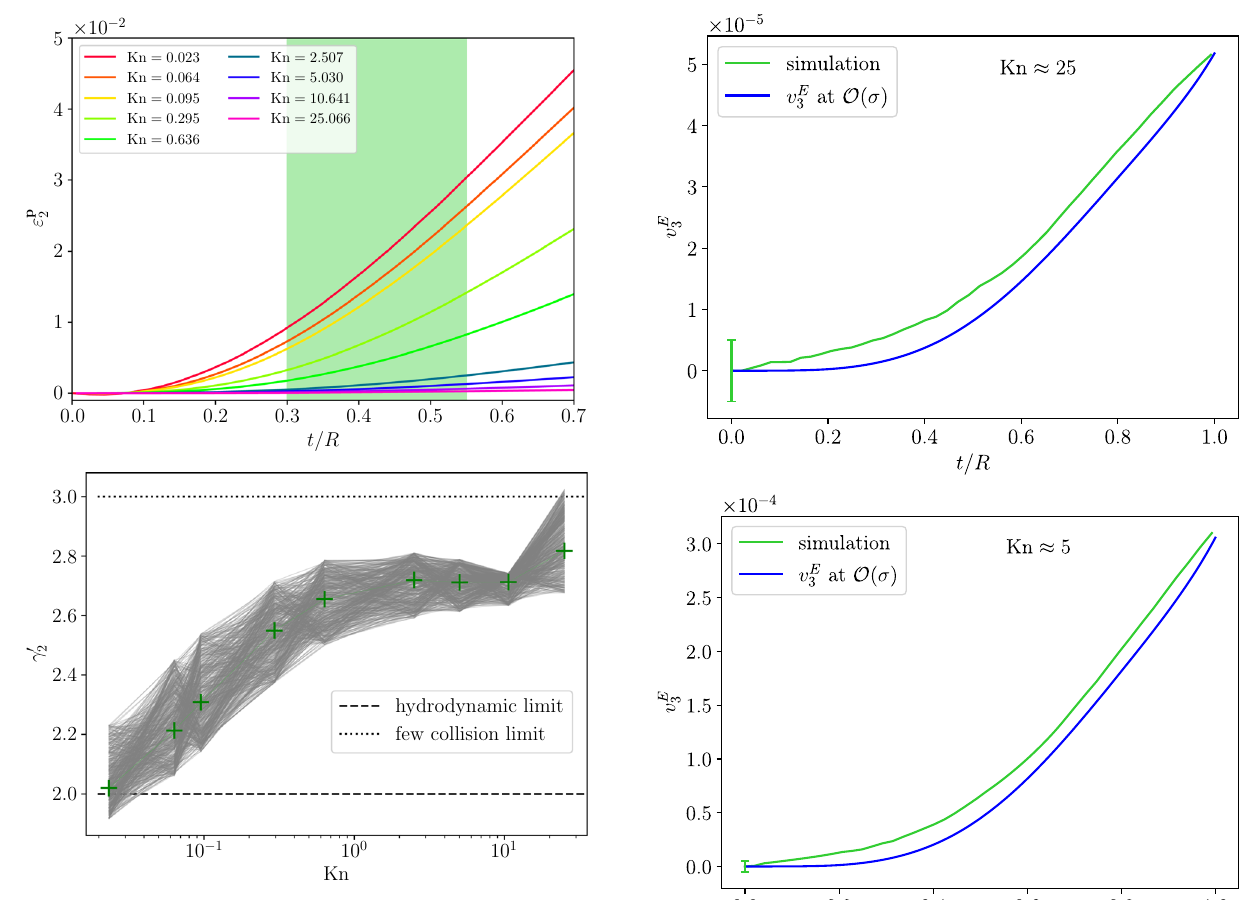
Fig. 11 Upper panel: early time dependence of ε p Knudsen numbers. Lower panel: dependence of the scaling exponent γ (cid:12)